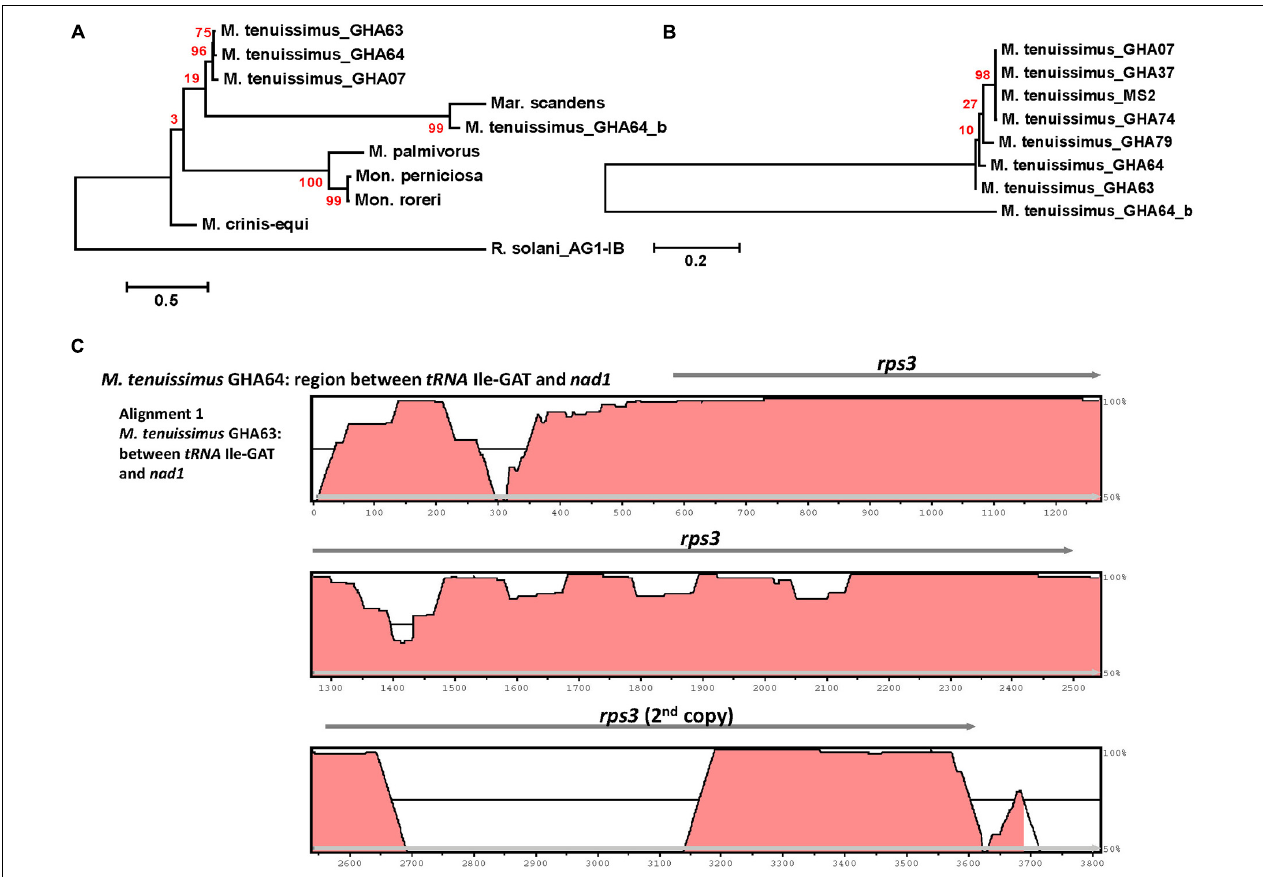
FIGURE 5 | Molecular phylogenetic analysis of four cacao thread blight associated pathogens from Ghana ( M. tenuissimus , M. palmivorus , M. crinis-equi , Mar. scandens ) and the Western hemisphere frosty pod rot ( Mon. roreri ) and witches’ broom ( Mon. perniciosa ) pathogens of cacao based on the rps3 gene. The analysis was based on amino-acid sequences of rps3 homologs from each isolate with 81 distinct alignment positions and 1,000 rapid bootstrap inferences. (A) Three M. tenuissimus isolates with other five species. (B) Seven isolates of M. tenuissimus . Sequences were combined and aligned using ClustalW2 tool under default setting and the phylogenetic tree was reconstructed using the Maximum Likelihood method. The tree is drawn to scale, with branch lengths measured in the number of substitutions per site. Analyses were conducted in MEGA6 (Tamura et al., 2013). (C) Visualization of rps3 gene region sequence alignment between M. tenuissimus isolate GHA64 and GHA63. The mVISTA program (http://genome.lbl.gov/vista/mvista/submit.shtml) was used to compare the section of mitochondrial genomes with default parameters in Shuffle-LAGAN mode and a sequence conservation profile was visualized in an mVISTA plot (Frazer et al.,